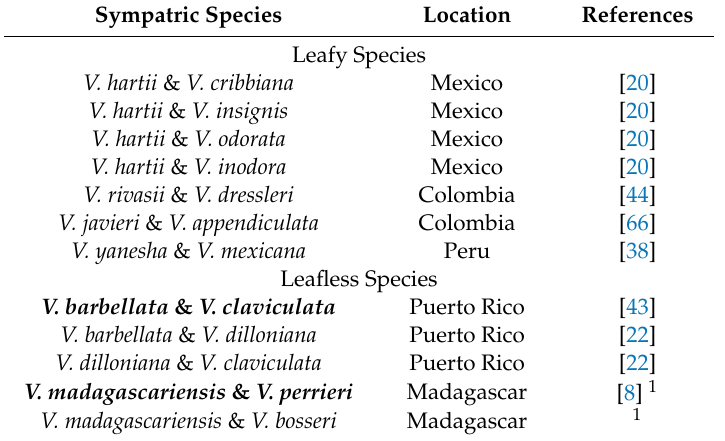
Table 3. Sympatric species recorded. Species for which hybridization was observed are highlighted in